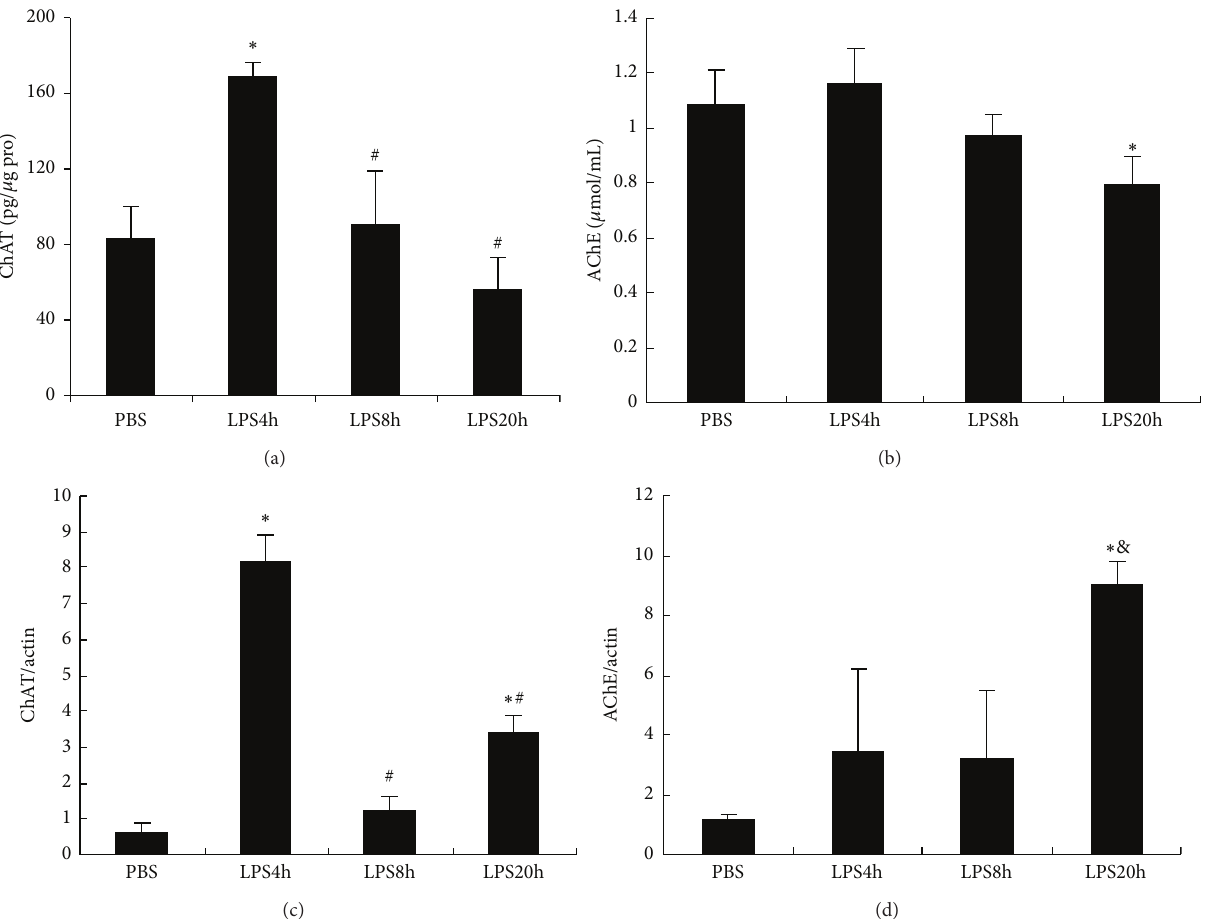
Figure 3: ChAT content within RAW264.7 cells, AChE concentration in the supernatant, and their mRNA expression level at the indicated time points of LPS exposure. (a) ChAT protein content in RAW264.7 cells lysates was detected by ELISA and the protein concentration of the lysates was determined by BAC method. The data were presented as pg ChAT per 𝜇 g protein. (b) AChE activity in supernatants of LPS treated RAW264.7 cells at the indicated time points, which was determined by the method of Ellman. (c) ChAT mRNA and (d) AChE mRNA expression levels in LPS treated RAW264.7 cells, which were determined by real-time PCR. Values are expressed as the ratio of ChAT or AChE to 𝛽 -actin. The data are representative of three individual experiments and presented as mean ± SD ( 𝑛 = 3 ), ∗ 𝑃 < 0.05 , # 𝑃 < 0.05 , and & 𝑃 < 0.05 when compared with PBS, LPS 4h, and LPS 8 h groups,